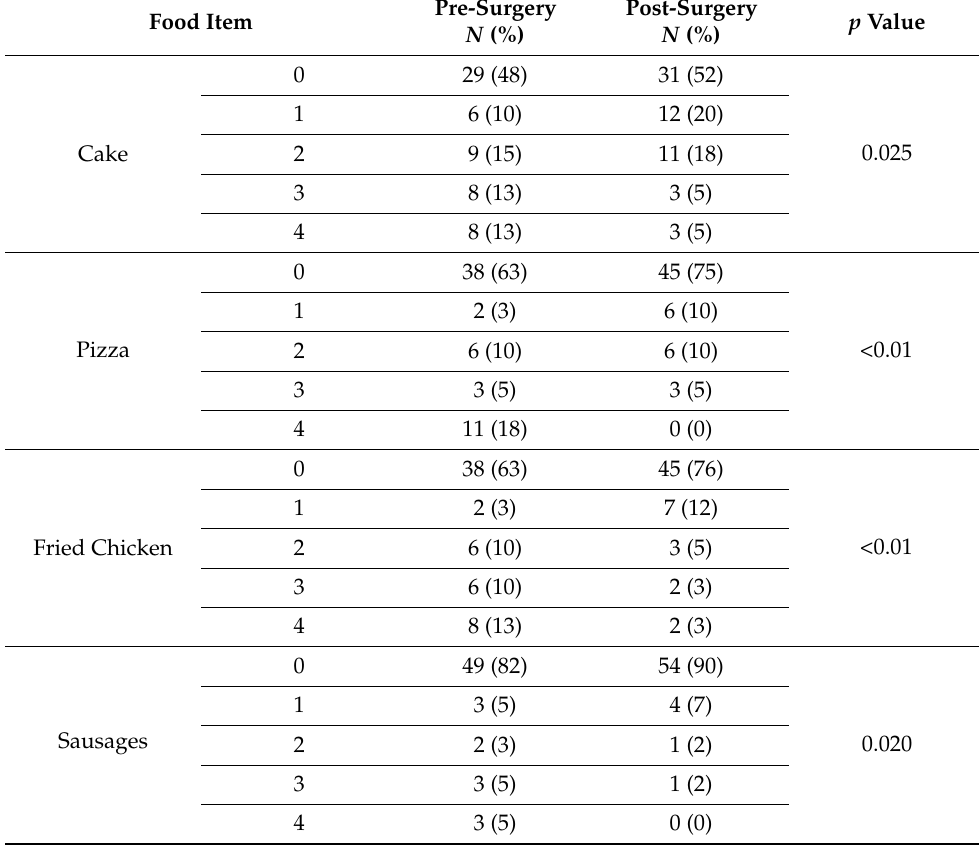
Table A1. Components of the food craving inventory prior and after surgery. Food Item